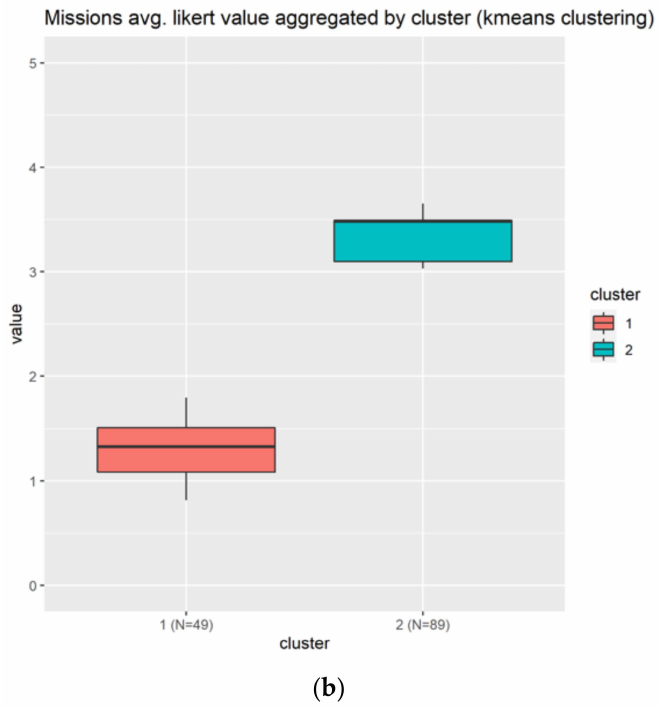
Figure 13. Results for the mission elements. Only two clusters are generated. The ( a ) subplots shows the results based on each question, meanwhile the ( b ) shows the information condensed in